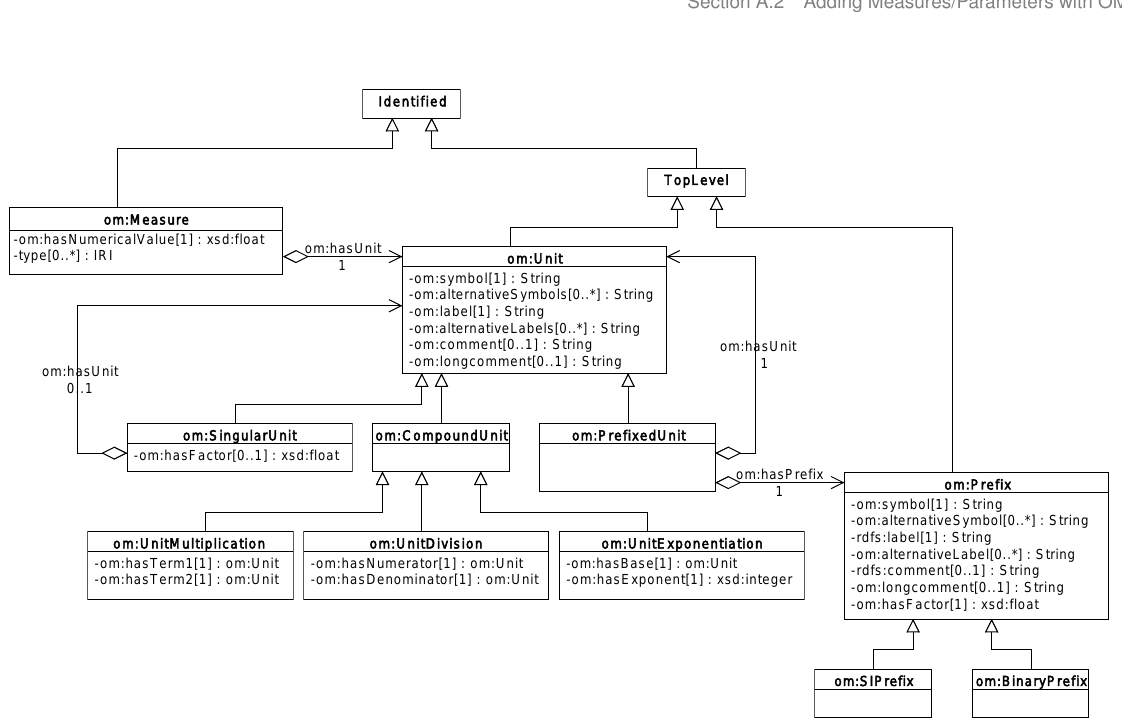
Figure 29: OM classes adopted by SBOL and their subclass relationships to Identified and